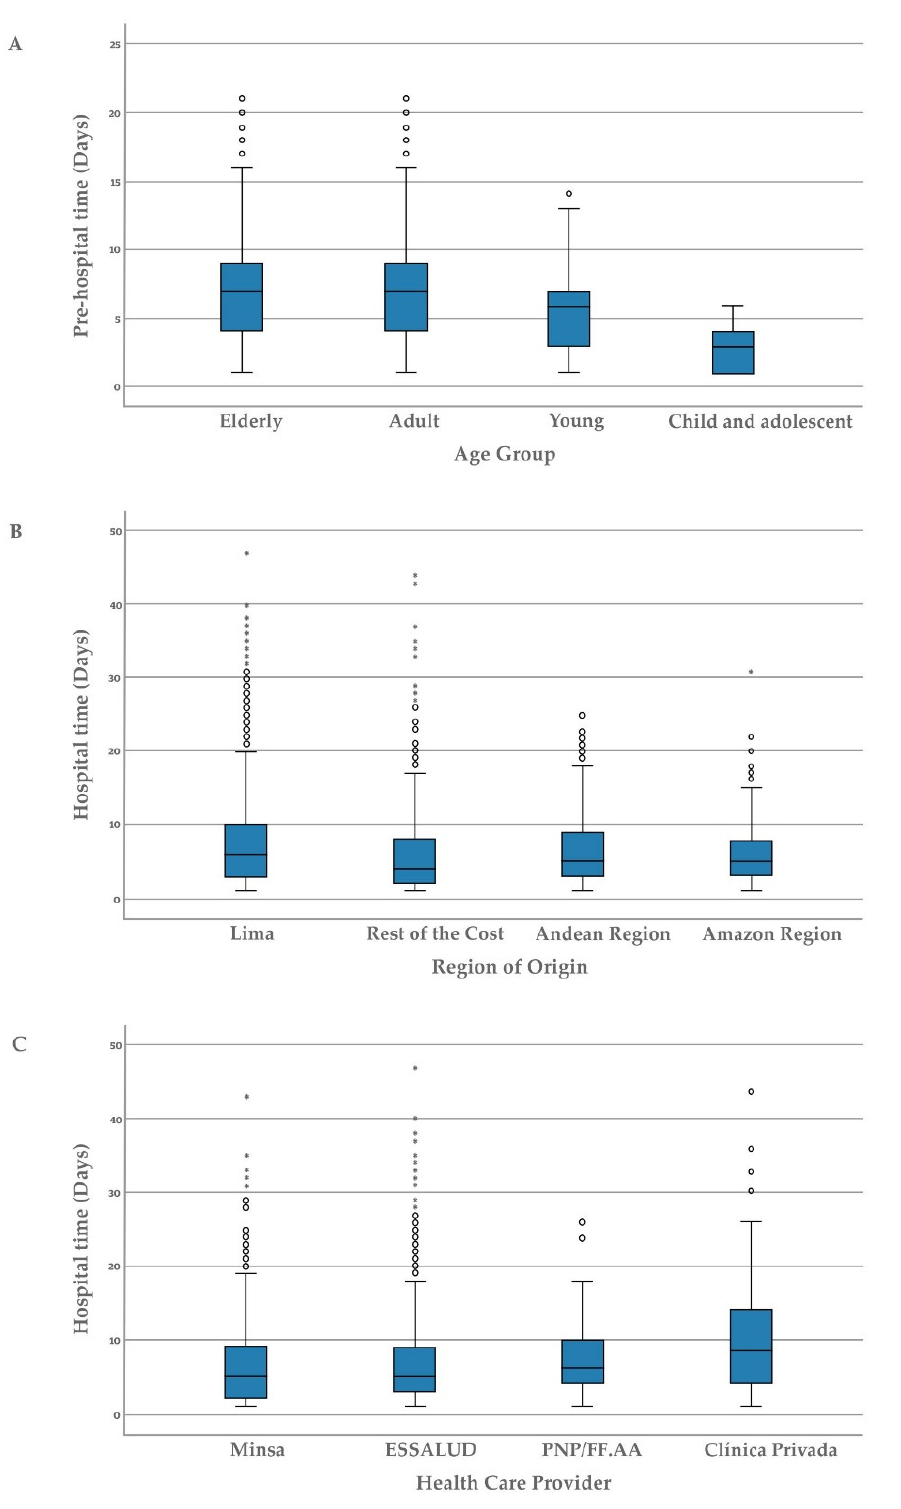
Figure 1. ( A ) Comparison of the pre-hospital time of deaths from COVID-19 according to age group. ( B ) Comparison of hospitalized time (days) of cases of COVID-19 death by region of residence. ( C ) Comparison of hospitalized time (days) of cases of COVID-19 death by healthcare provider.